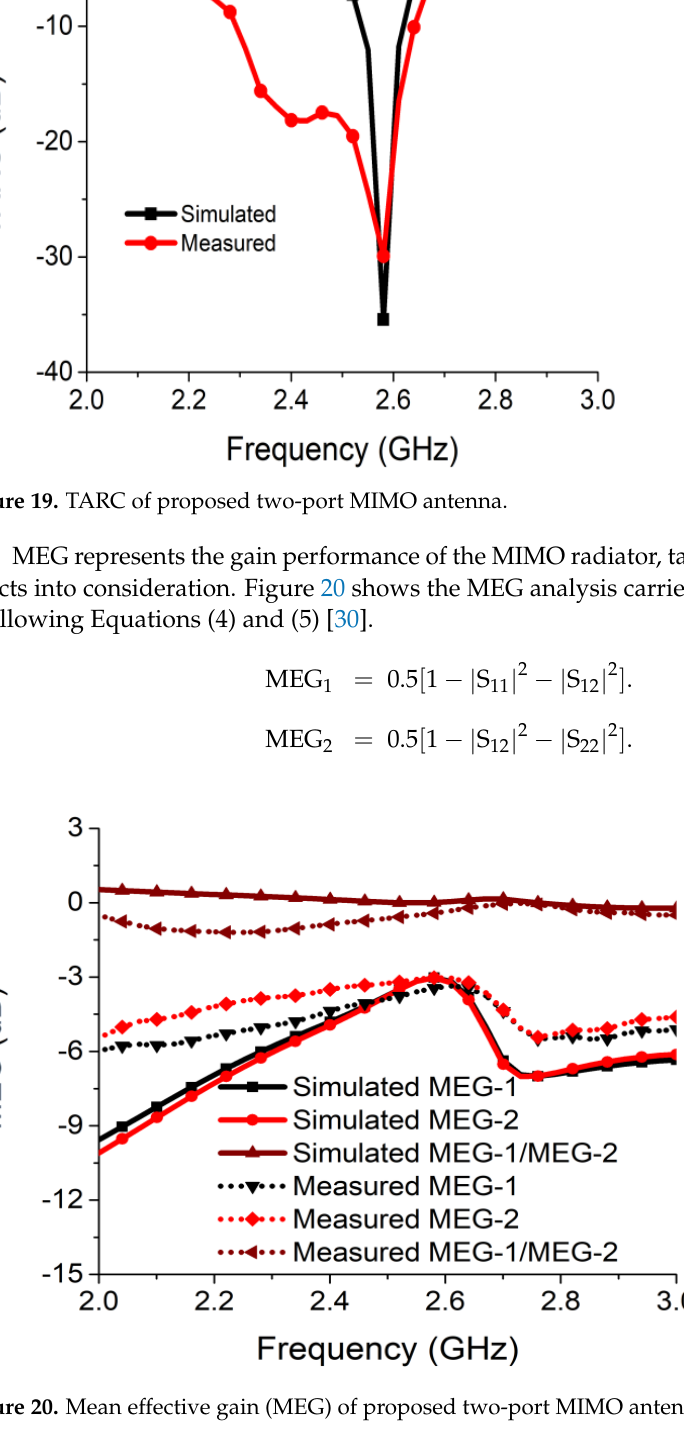
Figure 20. Mean effective gain (MEG) of proposed two-port MIMO antenna. The CCL measures the maximum value of channel loss that allows successful mes- sage transmission over the communication channel. The CCL should not be more than 0.4 bits/s/Hz for reliable communication. The CCL can be calculated from the formulas men- tioned in Equations (6) and (7) [31]. Figure 21 presents the CCL value, which was consid- erably below 0.042 bits/s/Hz in both simulation and measurement at the desired commu- nication frequency.